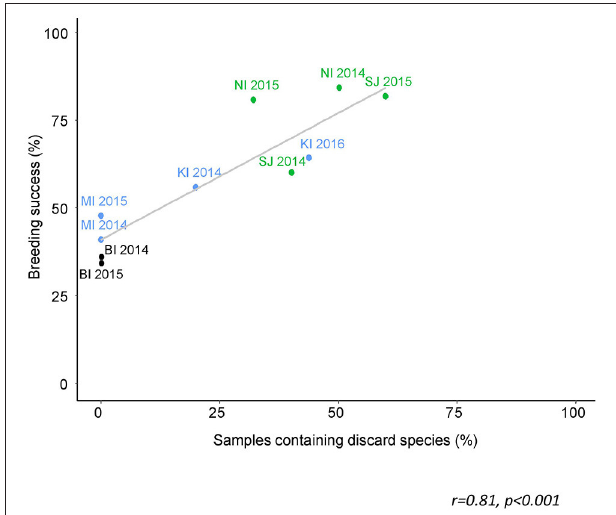
FIGURE 7 | The proportion of scat samples from black-browed albatrosses that contained discard species in relation to breeding success for that site and year. The colors corresponds to the current population trend: green—increasing; blue—stable; black—declining (ACAP, 2010; Wolfaardt, 2013; Poncet et al., 2017). These are minimum estimates of discard occurrence, including only the species that are not known to be naturally accessible to albatrosses (Table S1 in Supplementary Material). Albatross Islet suffered complete breeding success failure due to mammalian predation and was therefore excluded from the